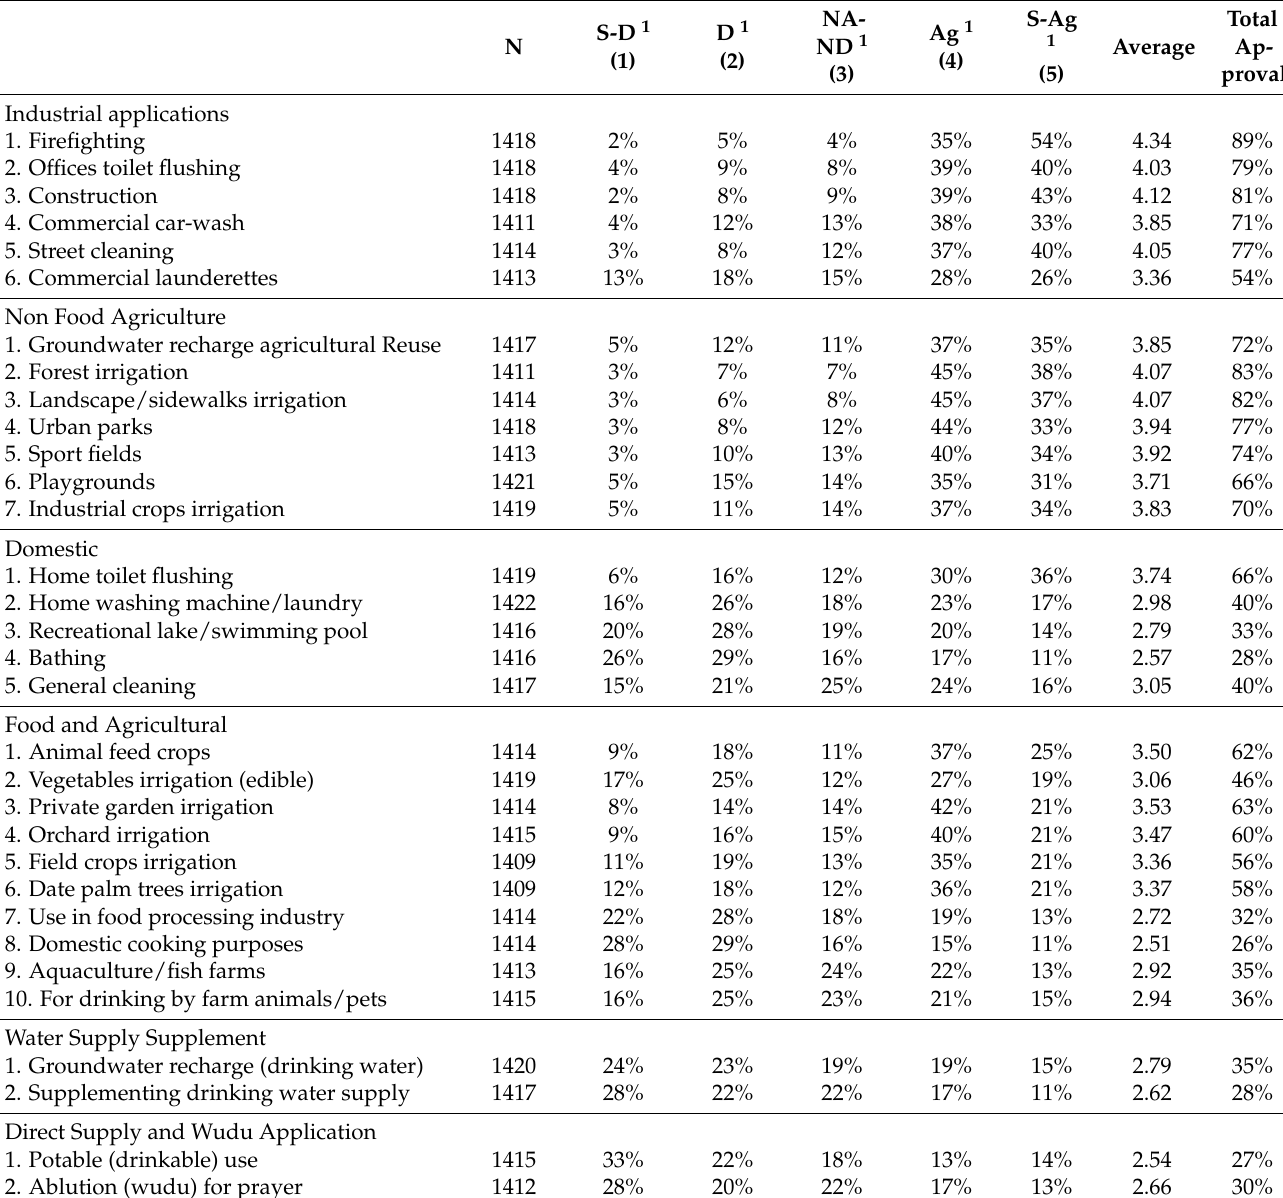
Table 5. Public acceptance of TWW reuse in various